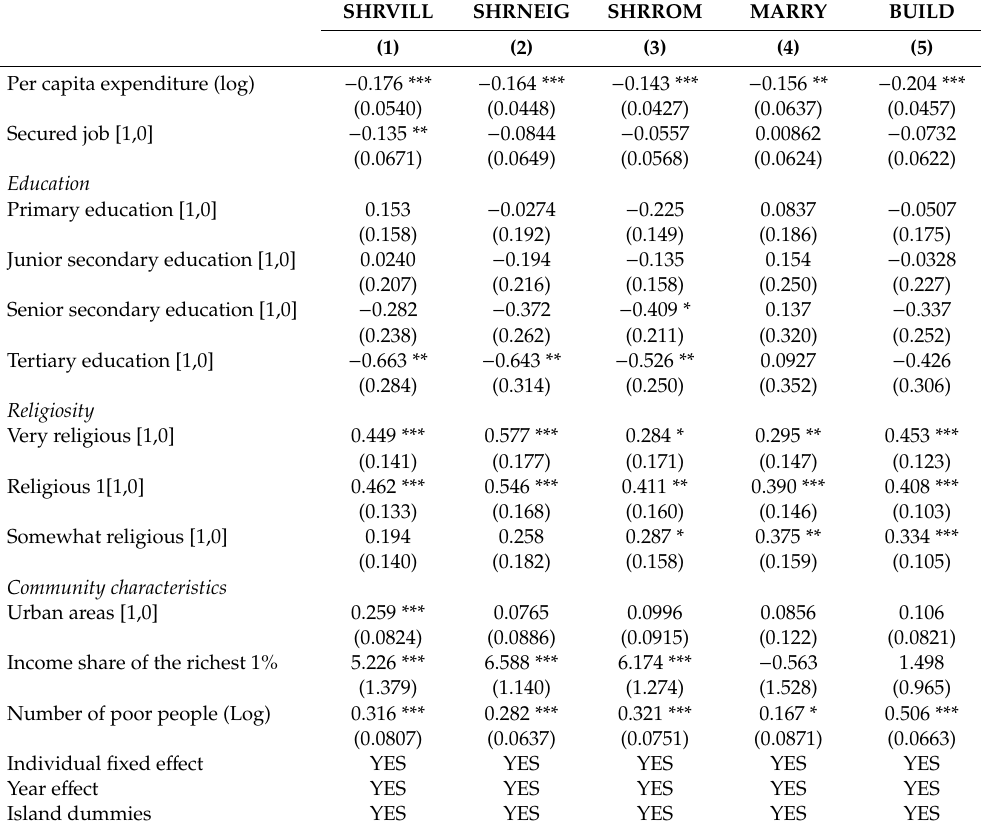
Table A2. Regression results (Fixed-e ff ect conditional logit Model), Richest